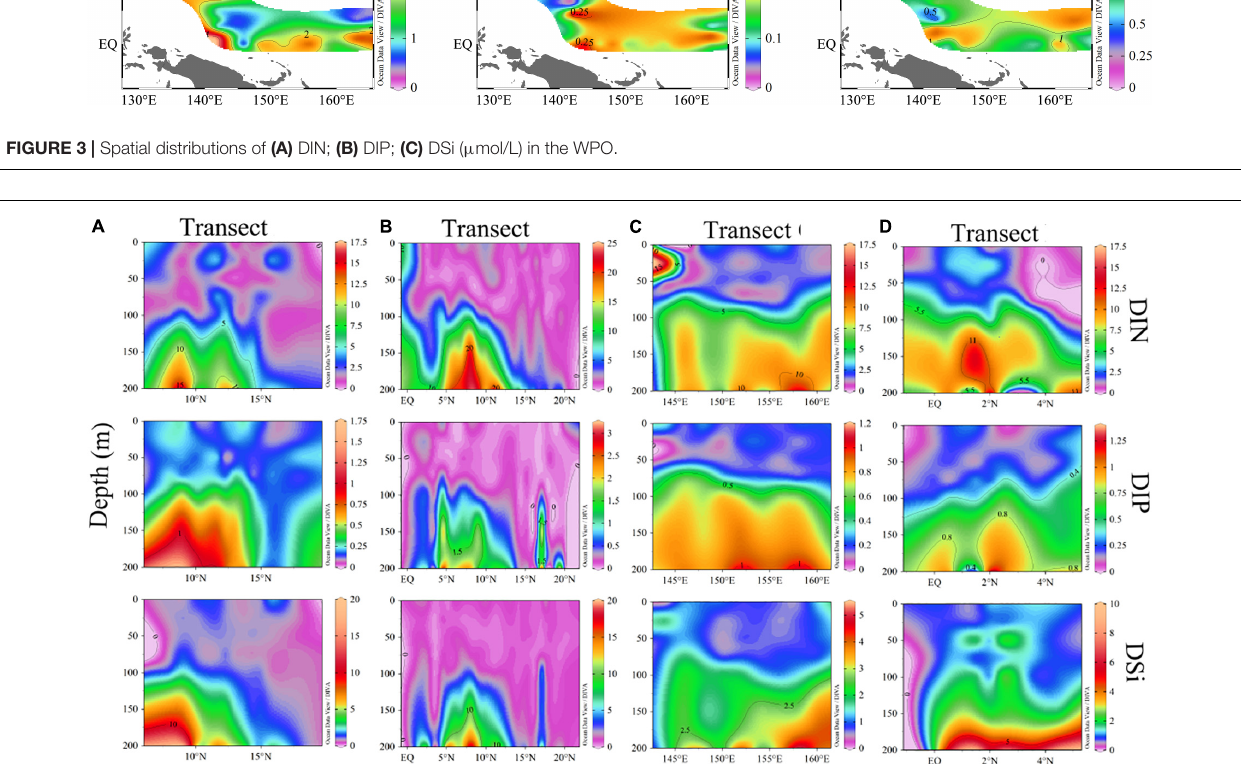
FIGURE 4 | Section profile for concentrations of DIN, DIP, and DSi ( µ mol/L) along (A–D)